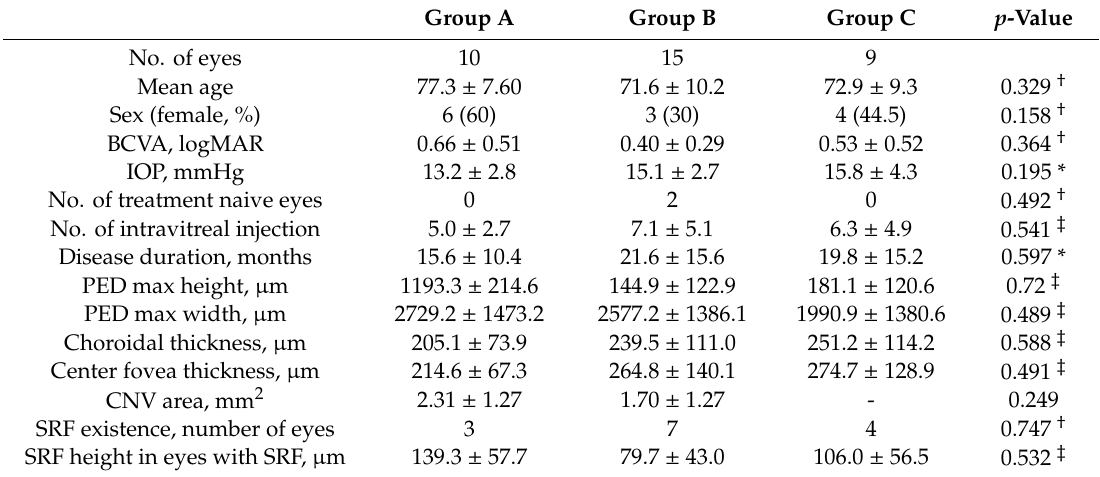
Table 5. Parameters of OCT according to choroidal neovascularization (CNV) group in eyes with type 1